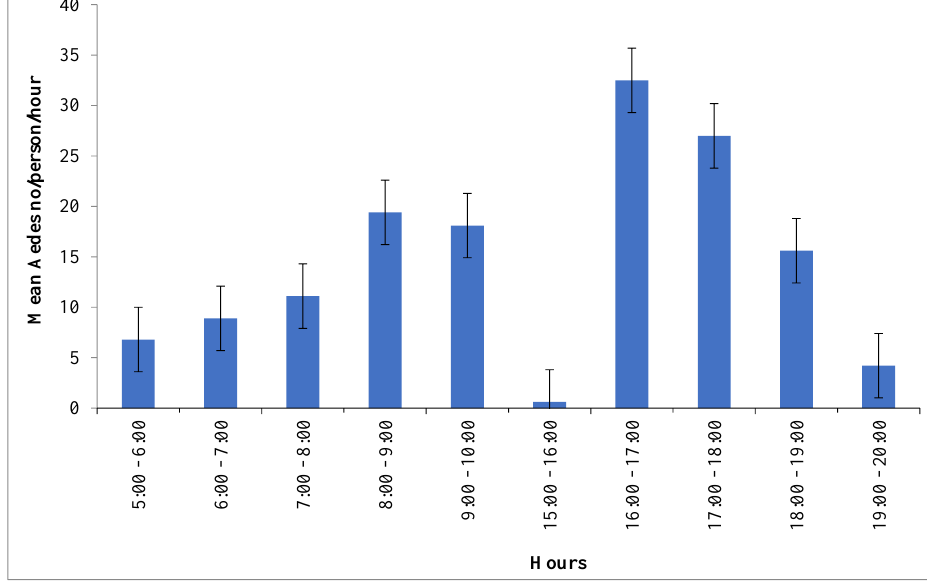
Table 2. Abdominal condition of Ae. simpsoni complex from different collection sites by different entomological sampling techniques in southwestern Ethiopia .